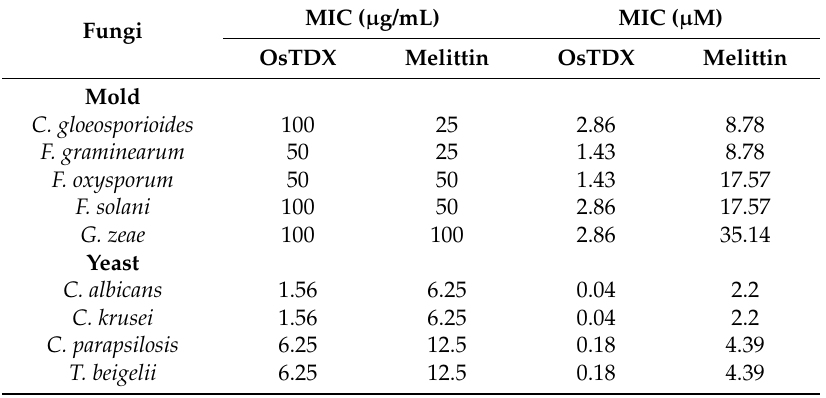
Table 1. Antifungal activity of OsTDX and melittin against various pathogenic fungi. MIC ( µ g/mL) MIC ( µ M) Fungi OsTDX Melittin OsTDX Melittin